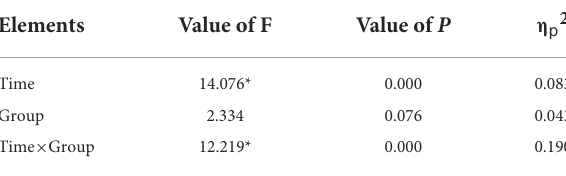
TABLE 5 Repeated measures analysis of variance on participants’ uncorrected distance visual acuity. Elements Value of F Value of P η p